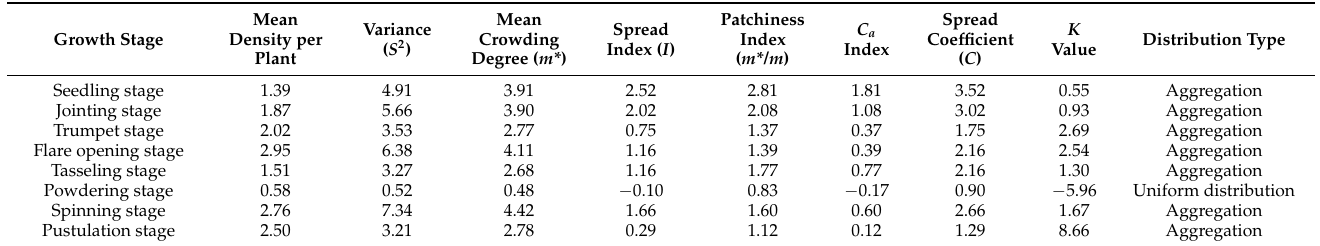
Table 3. Total sample density and aggregation index of S. frugiperda larvae in mountain maize fields in